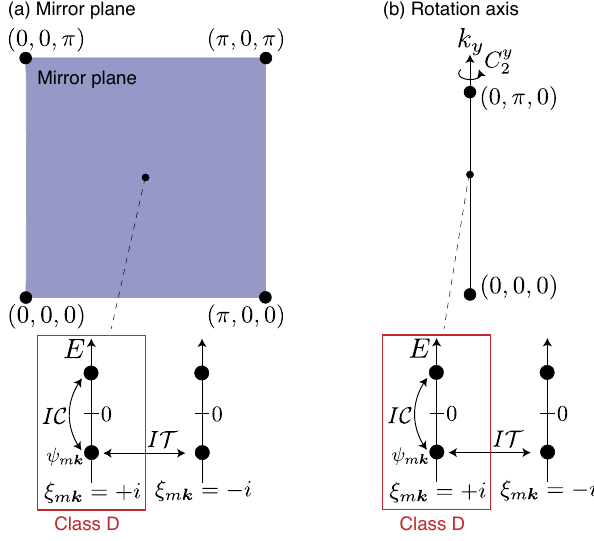
FIG. 1. Illustration of the action of symmetries discussed in Sec. II. There are two irreducible representations in the mirror plane ( k - k plane) [(a)] and the rotation axis ( k z x are invariant under I C but exchanged by I T . As a result, the EAZ classes for the irreducible representations are class D, and, thus, two Z 2 topological invariants (Pfaffian invariants) are defined at every point in the mirror plane and the rotation axis (except for high-symmetry